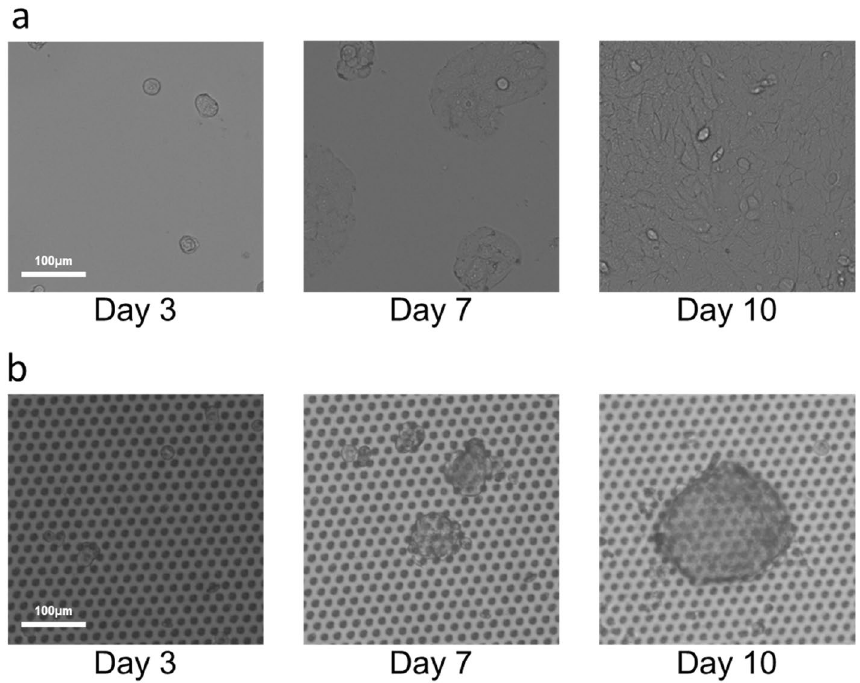
Figure 6. Culturing of the captured CTCs on the glass filter. H358 cells after isolation on a petri dish ( a ) and a glass filter with non-adhesive coating ( b